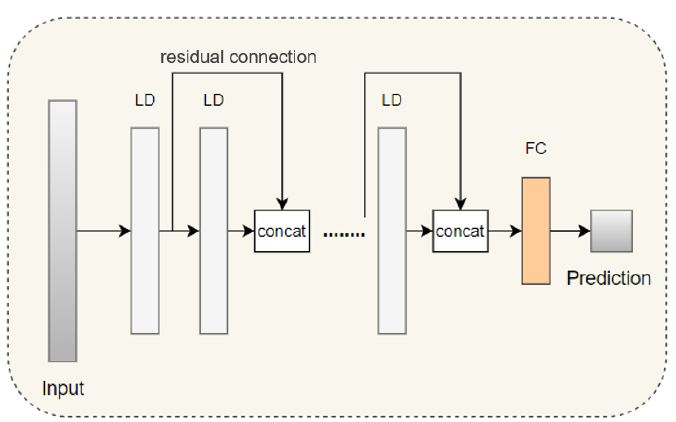
Figure 2. The network structure of LRN, where LD is the combination of linear layer and dropout layer and FC is a fully connected layer. The concat donates concatenation with an activation